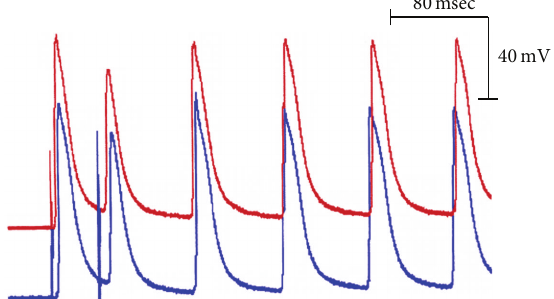
Figure 10: Change of direction in the propagation of the wavefront. Observe that the first three responses (basic, test, and first reentrant) are propagated from the stimulation site towards the rest of the preparation, whereas the last three following reentrant responses propagate in the opposite